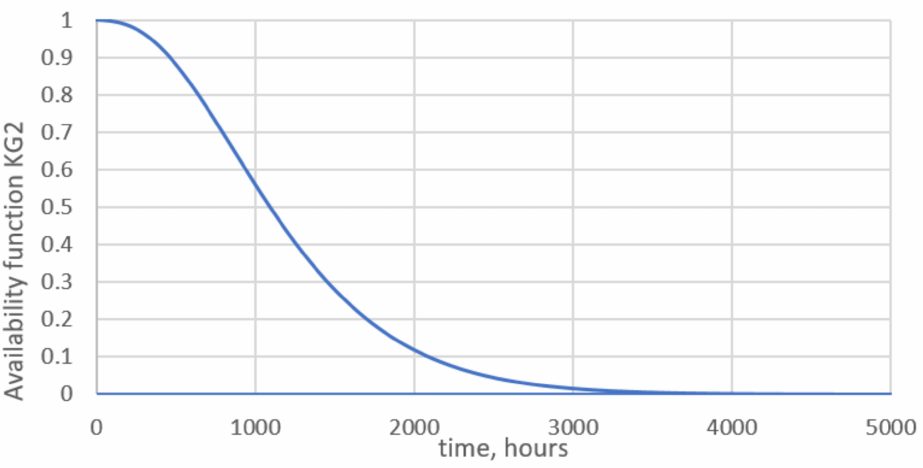
Figure 4. The availability function of the hierarchical ramified system in the availability condition k = 18.